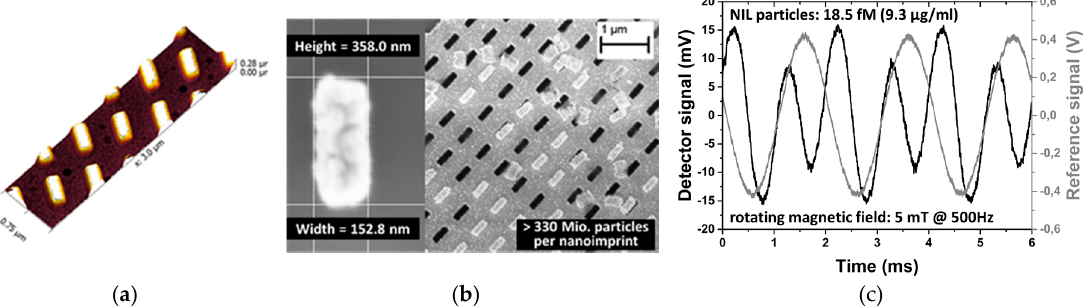
Figure 4. AMF and SEM image of nanoimprinted Au-particles (40 nm) before ( a ) and ( b ) during/after lift-off, respectively; ( c ) Typical rotational dynamics measurements for nanoimprinted hybrid nanoparticles consisting of Au (25 nm)/Fe (8 nm)/Au (25 nm) multilayers and a size of 150 × 360